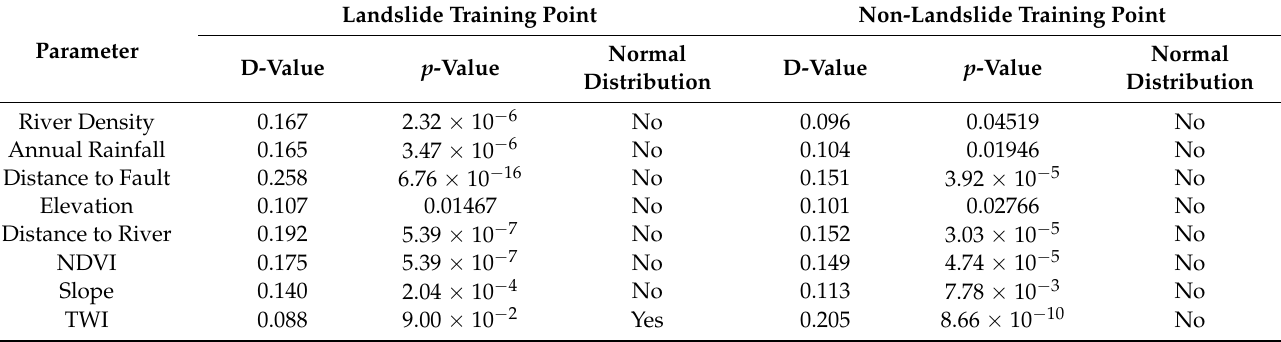
Table 3. Result of K-S test training